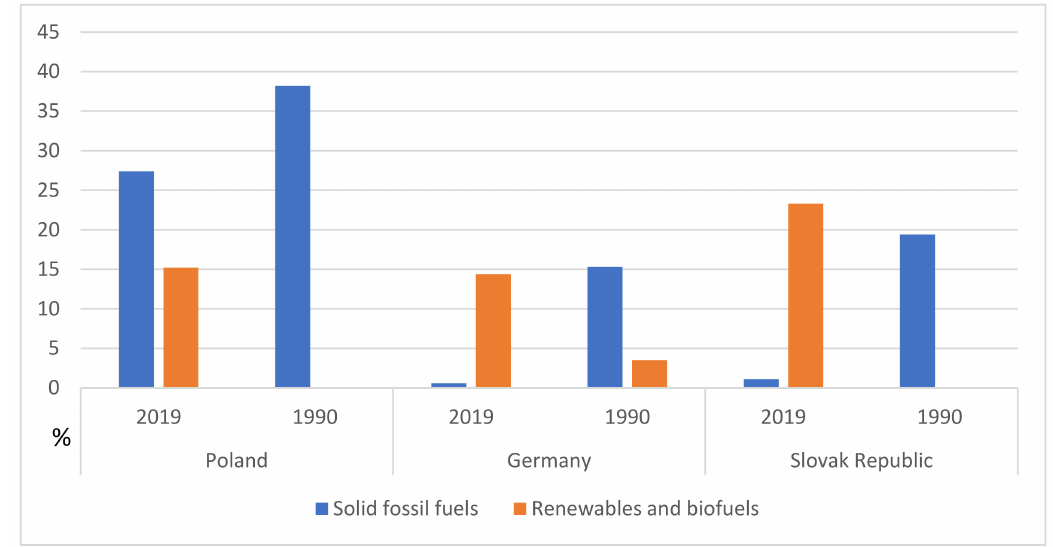
Figure 7. Use of solid fuels and renewable energy sources in the Polish, German and Slovak household sector in 2019. Scheme